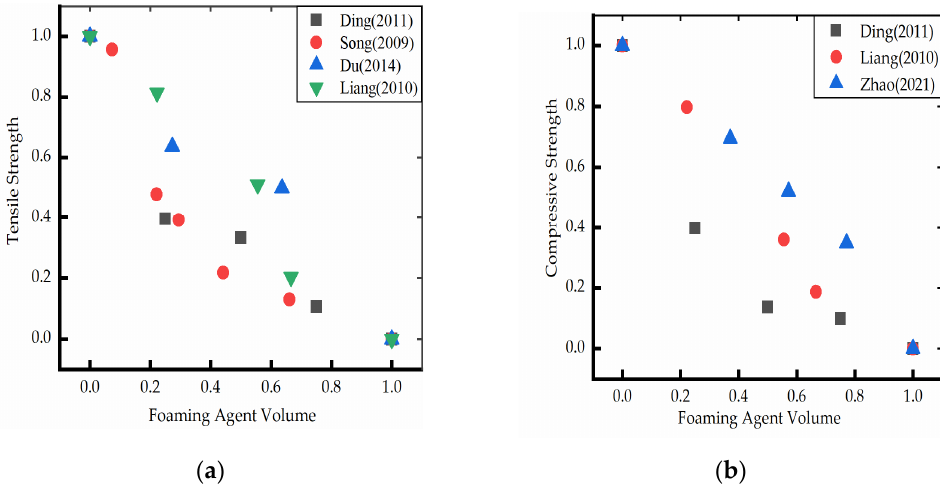
Figure 2. ( a ) Relationship between foaming agent (water) and tensile strength (normalization) [17,19,20,26]; ( b ) Relationship between foaming agent (water) and compressive strength (normalization) [17,26,28].